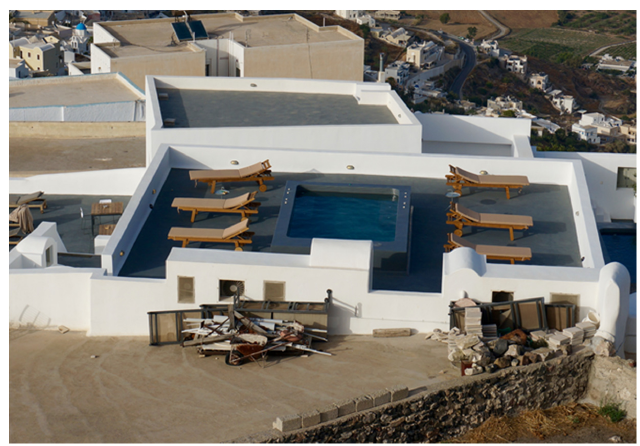
Figure 1. Example of rooftop water features, spaces in previous centuries that would serve as catchment areas for collecting rainwater into the household cistern.